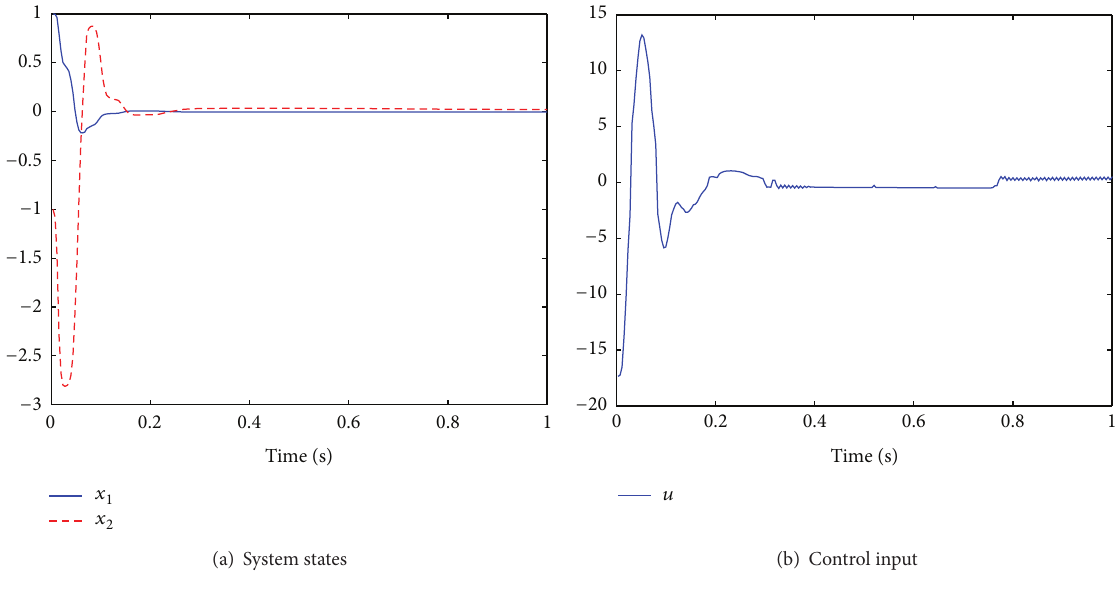
Figure 1: The responses of closed-loop system (41) and